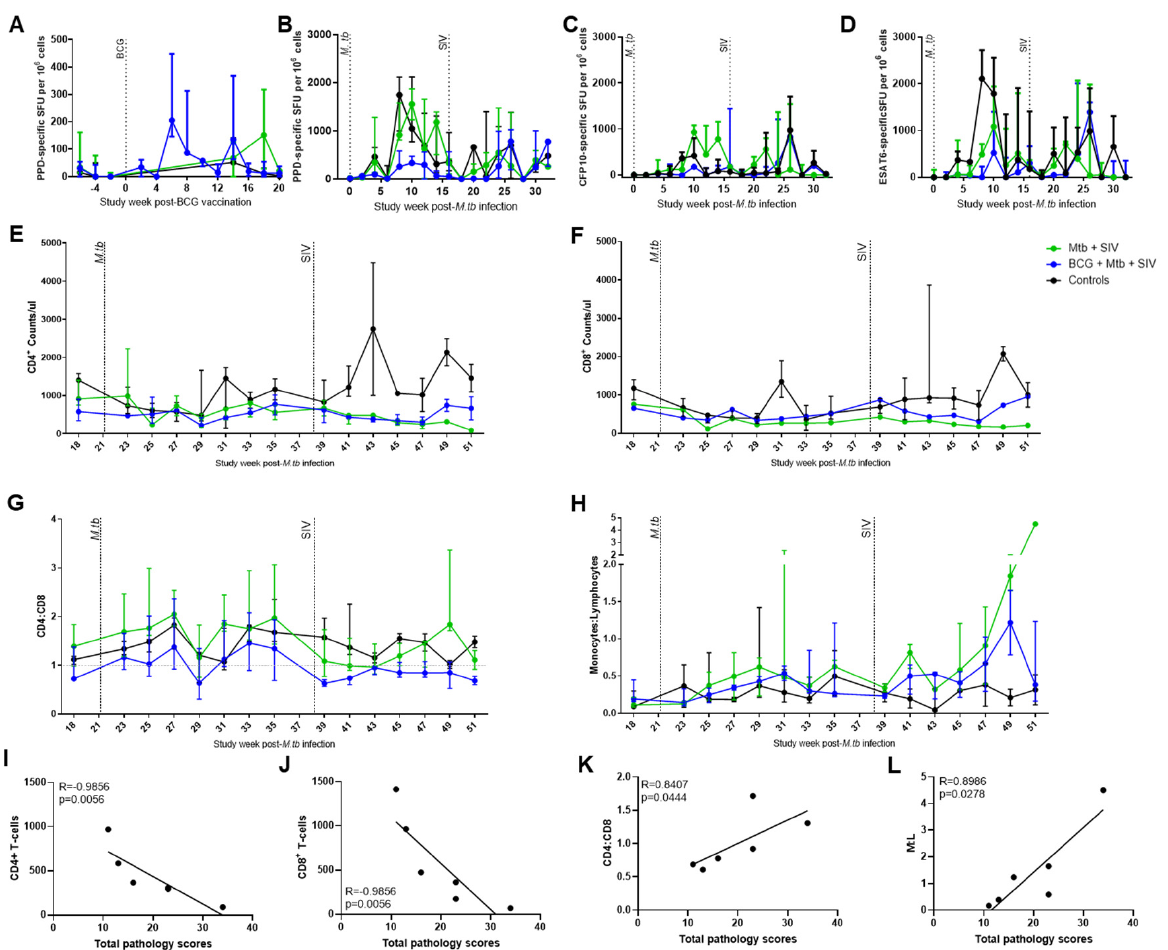
Figure 3. M. tb-specific IFN γ response measured by ELISPOT and CD4+ and CD8+ counts and CD4/CD8 ratio and M/L ratio determined by flow cytometry. ( A ) PPD-specific IFN γ ELISPOT SFU measured following BCG vaccination; ( B ) PPD-specific IFN γ ELISPOT SFU measured following M. tb and SIV infection; ( C ) ESAT6-specific IFN γ ELISPOT SFU measured following M. tb and SIV infection; ( D ) CFP10-specific IFN γ ELISPOT SFU measured following M. tb and SIV infection; ( E ) CD4+ cells/ µ L in whole blood following M. tb and SIV infection; ( F ) CD8+ cells/ µ L in whole blood following M. tb and SIV infection; ( G ) CD4/CD8 ratio determined in whole blood following M. tb and SIV infection; ( H ) M/L ratio defined in whole blood following M. tb and SIV infection. ( I – L ) Spearman’s Rank correlations of all SIV infected animals (Group 1 (M. tb + SIV) and Group 2 (BCG + M. tb + SIV)) p=0.05 ( I ) CD4+ T-cells correlation with total pathology scores, ( J ) CD8+ T-cells correlation with total pathology scores, ( K ) CD4:CD8 ratio correlation with total pathology scores, ( L ) M:L ratio correlation with total pathology scores. Blue = Group 1: BCG + SIV + M. tb, green = Group 2: SIV + M. tb, black = Group 3: M. tb only. Median and interquartile range